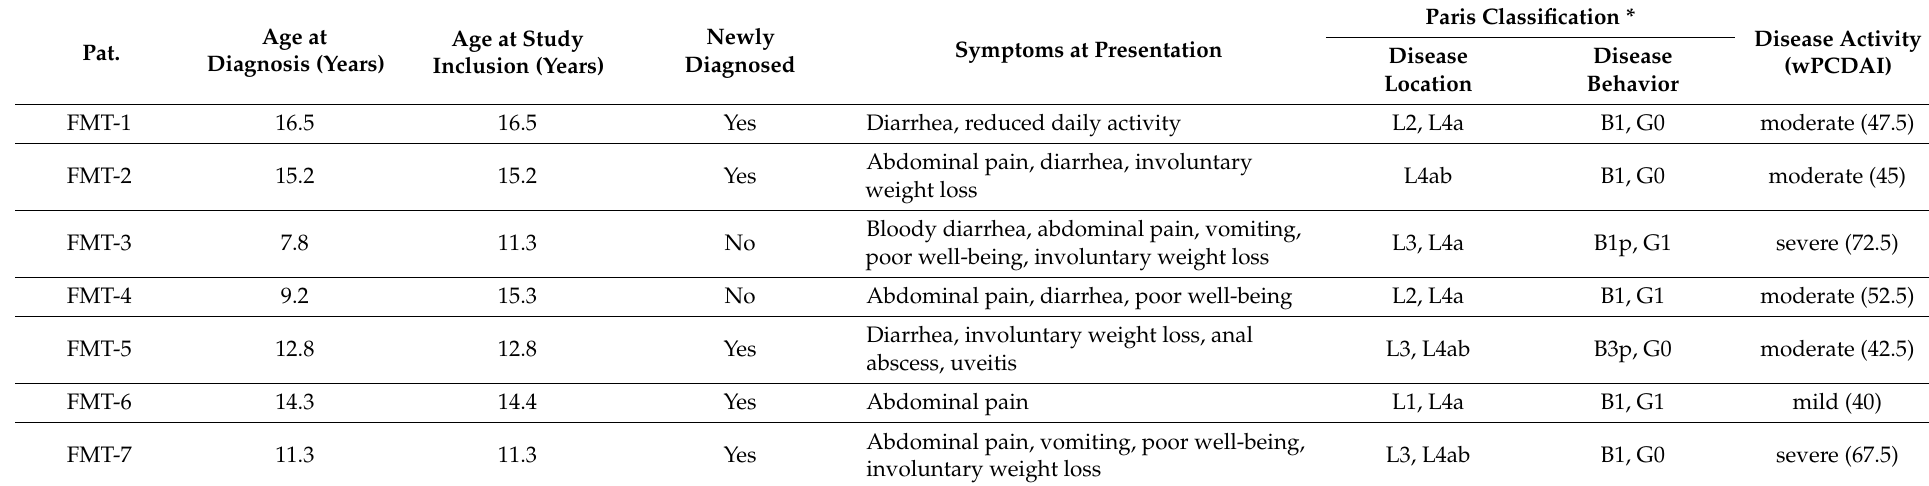
Table 1. Demographic and clinical characteristics of the study population at